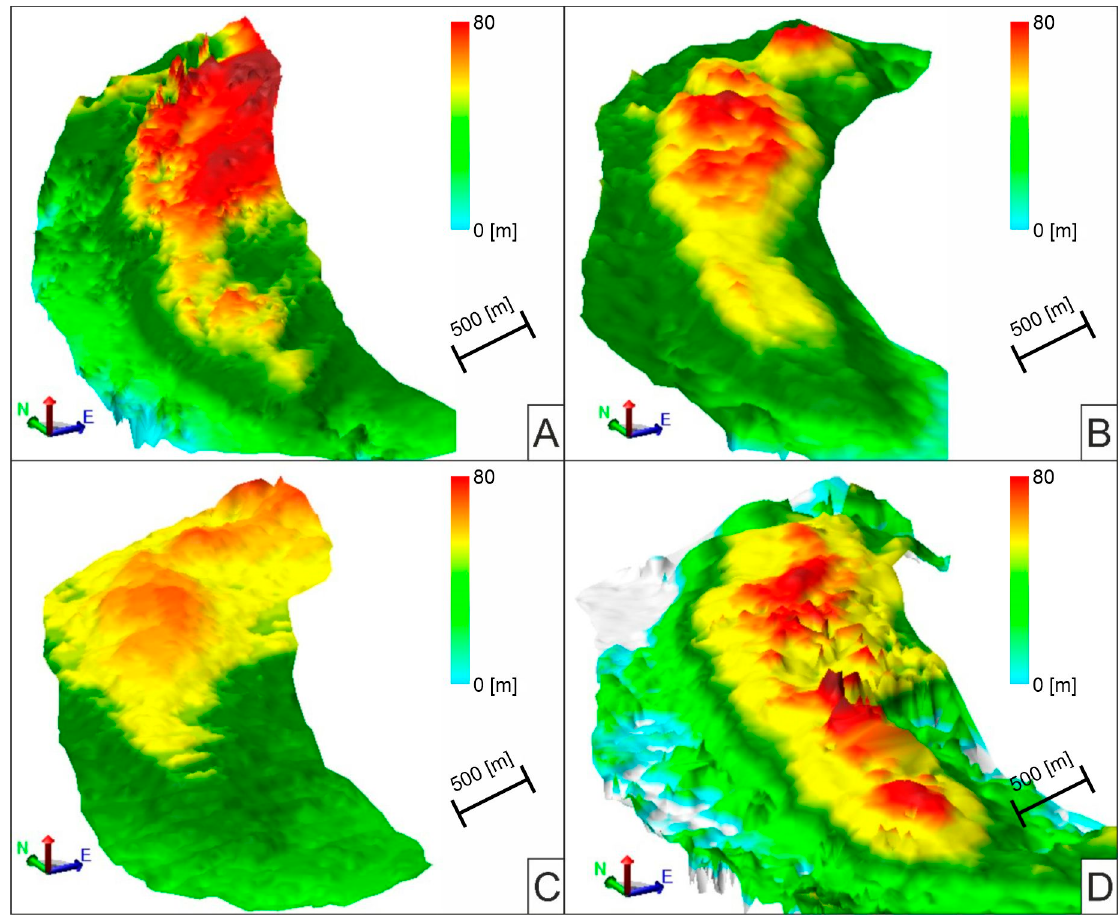
Figure 4. DTMs based on photogrammetric images from different measurement periods: ( A ) 1936; ( B ) 1960; ( C ) 1990; ( D ) 2011.